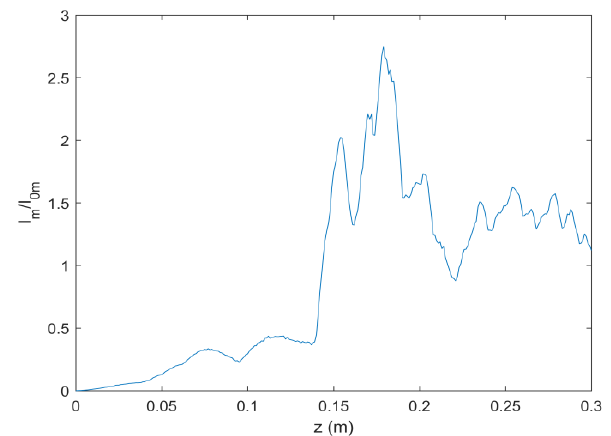
Figure 6. The “abruptly autofocusing” property of RHCP component .